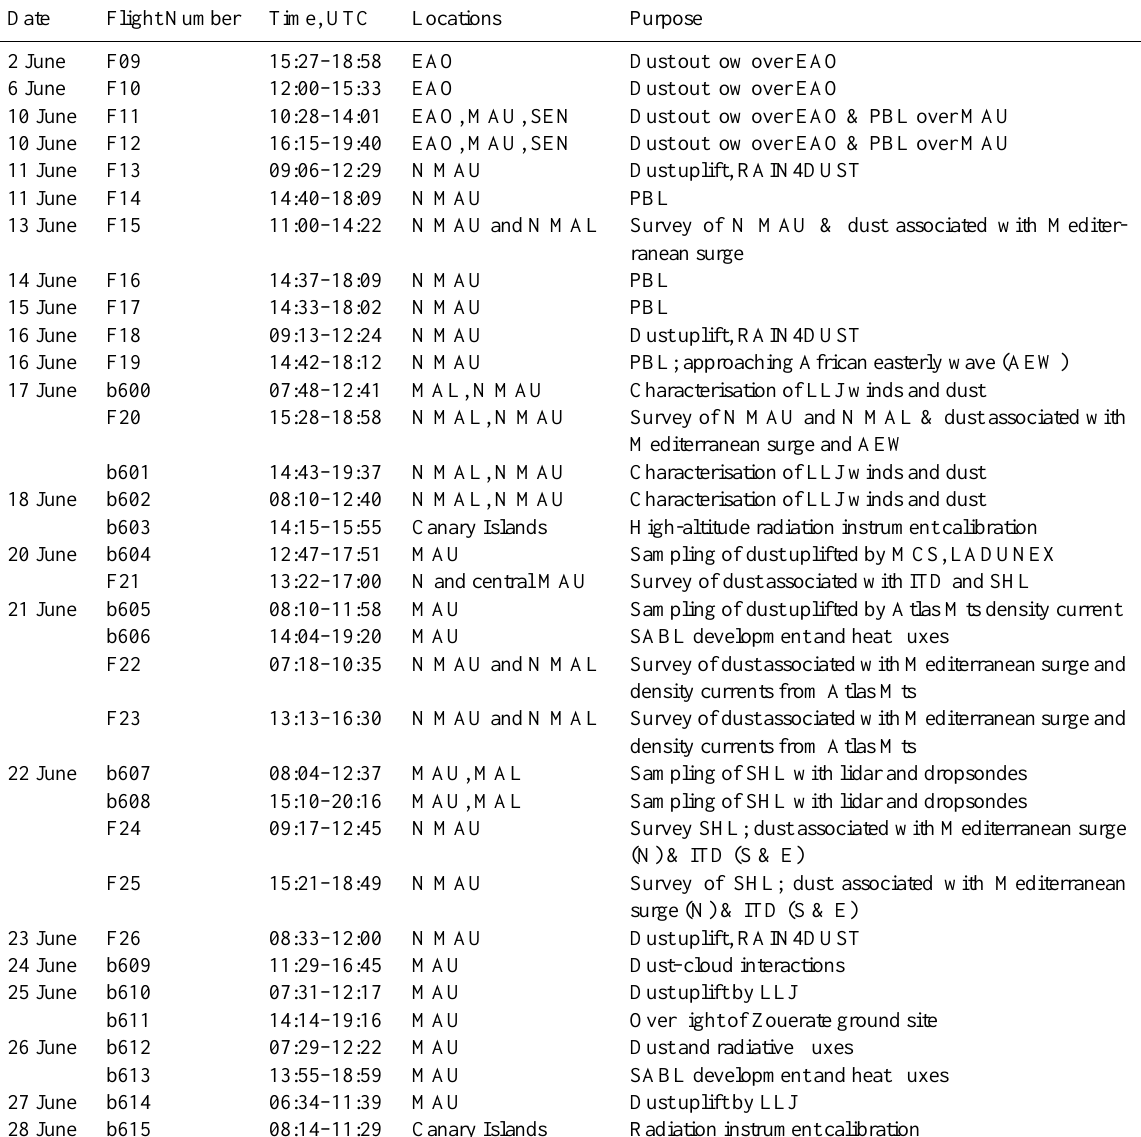
Table 6. June 2011 IoP Flights. Flight numbers with preceding “b” indicate BAe146 flight, with preceding “F” indicate Falcon flight. Abbreviations: EAO is the eastern Atlantic Ocean, MAU is Mauritania, MAL is Mali, SEN is Senegal, FUE is Fuerteventura, LLJ is low- level jet, MCS is mesoscale convective system, PBL is planetary boundary layer, ZOU is the Zouerate